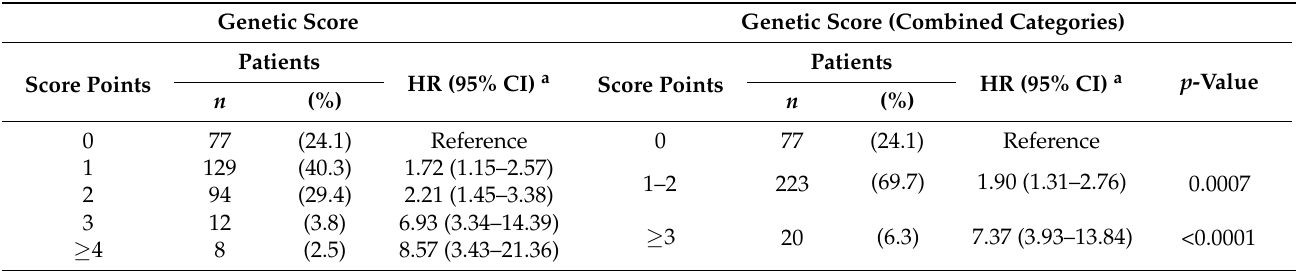
Table 4. Hazard ratios (HR) and 95% confidence interval (CI) for overall survival in the 320 patients with mCRC according to the genetic score.